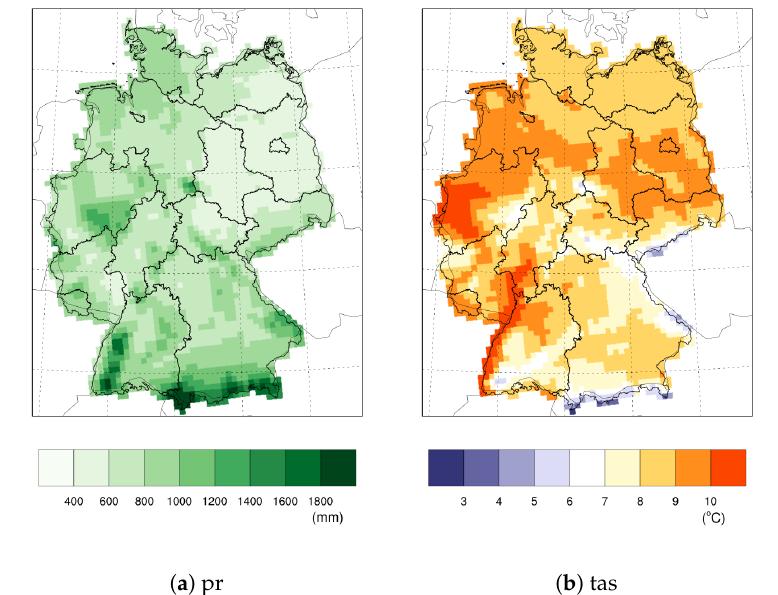
Figure 2. Downscaled results for the modeling chain historical—CanESM5 run1—EPISODES2018. Shown are the yearly mean values over the period 1971–2000 for ( a ) precipitation (pr) and ( b ) temperature (tas). The project ReKliEs-De [16] compared the RCM and ESD data sets. The results, as shown as thermo-pluviograms in Figure 1, are based on data from the EURO-CORDEX downscaling initiative [15] and the German research project ReKliEs-De [16], extended with results downscaled by EPISODES. The results indicate that climate trends that are based on the downscaling with EPISODES are comparable to other dynamical (RCM) and statistical (ESD) downscaling